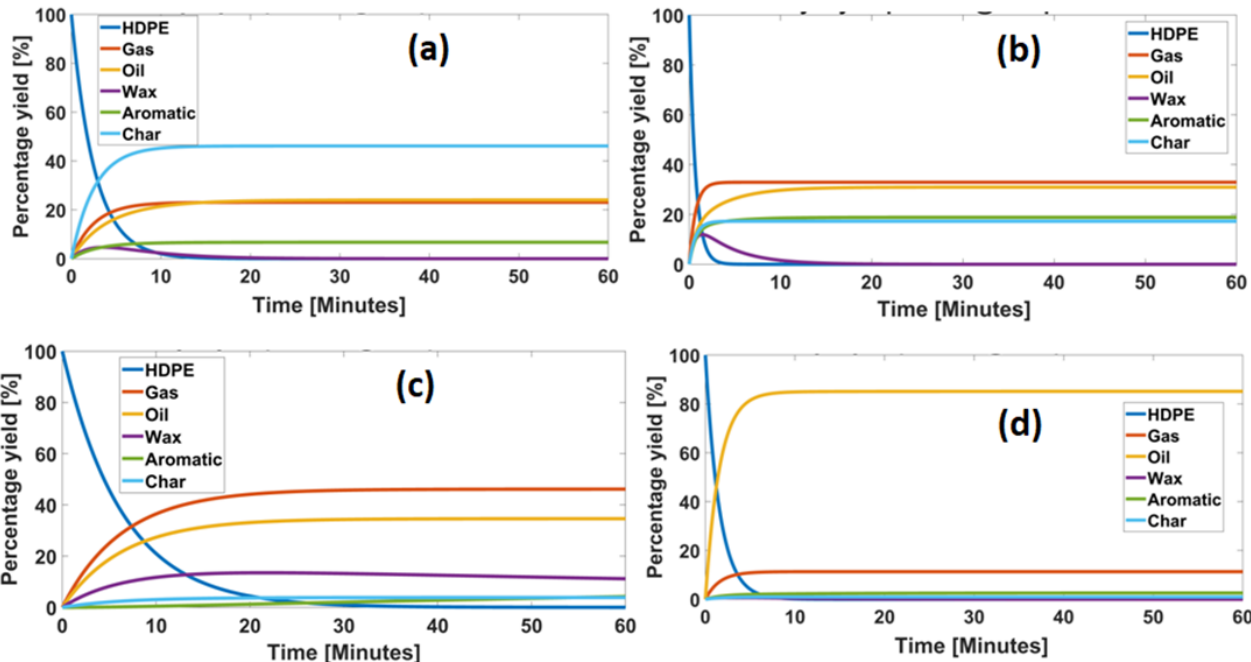
Figure 6. Comparison of the percentage yields of ( a ) the experimental rate constants at 500 °C, ( b ) the statistical rate constants at 500 °C, ( c ) the experimental rate constants at 550 °C, and ( d ) the statistical rate constants at 550 °C.